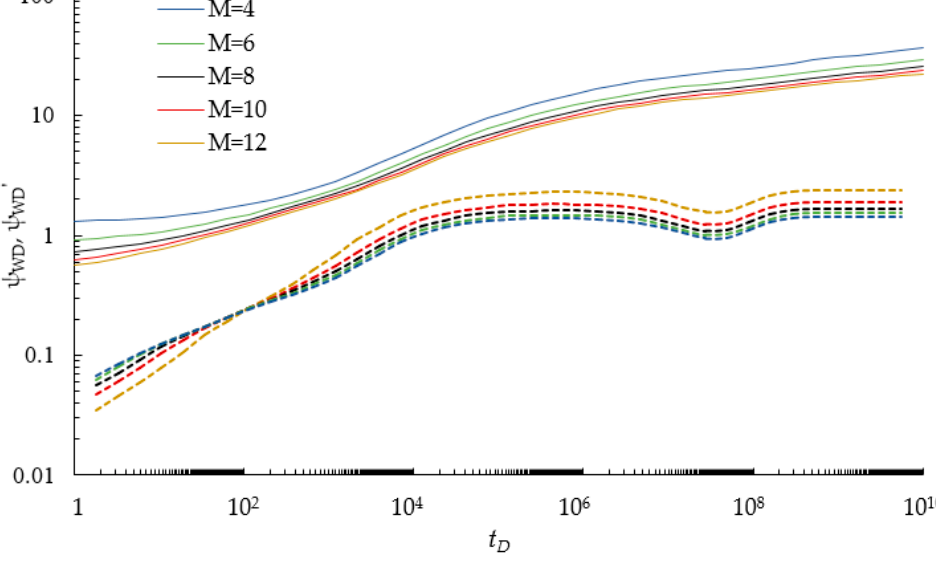
Figure 8. Sensitivity analysis on the number of divided fracture segments.